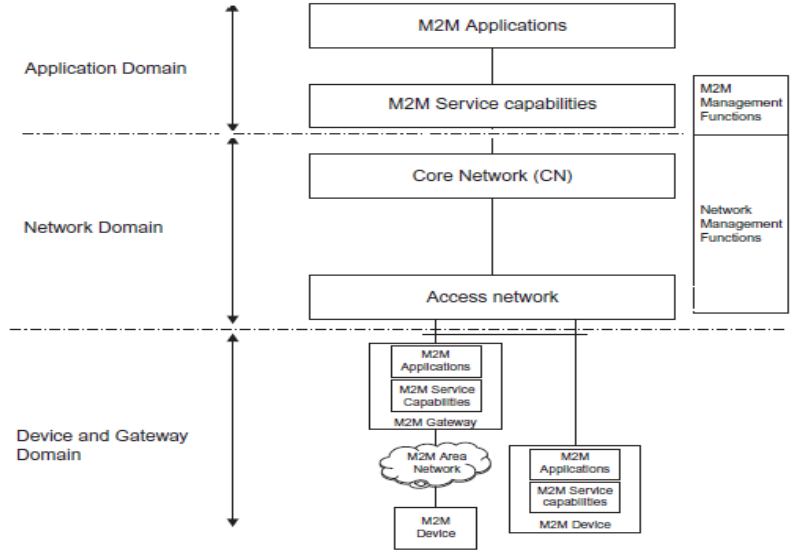
Figure 1. ETSI M2M system architecture—Functional view.